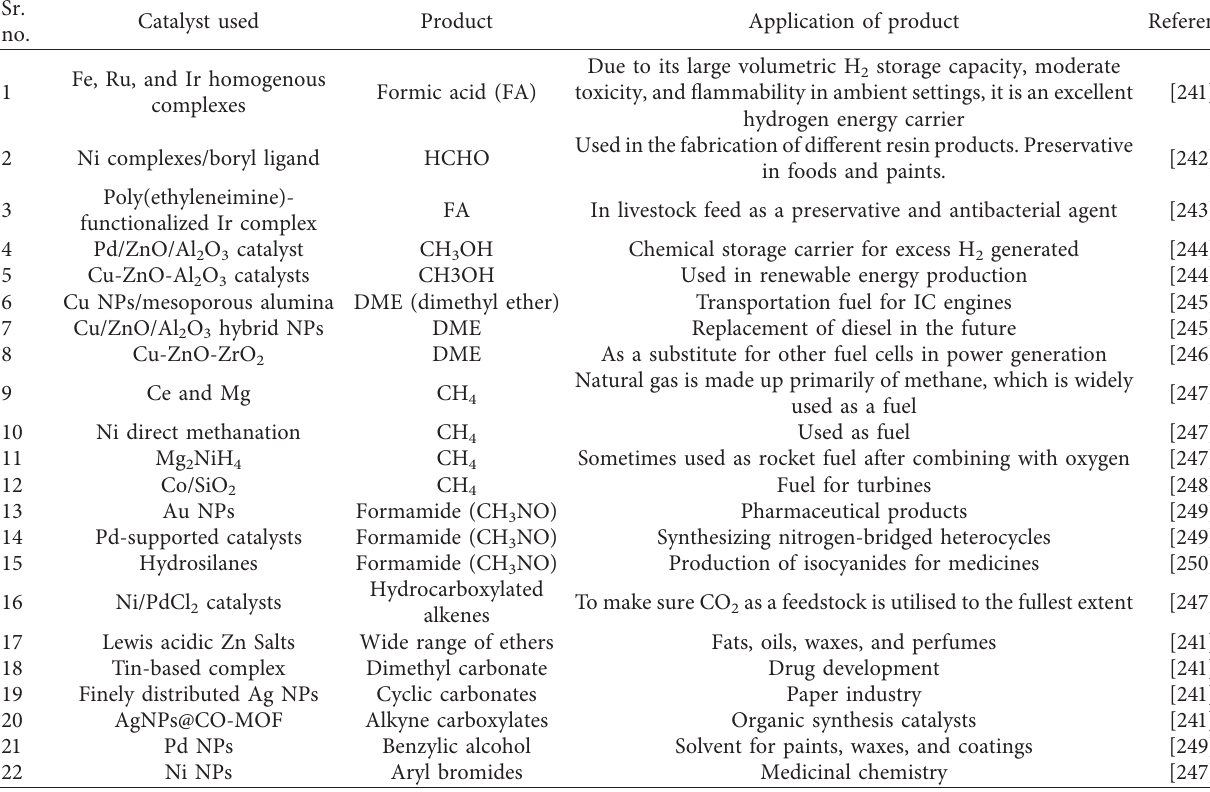
Table 11: Catalyst used in laboratories, their products, and respective